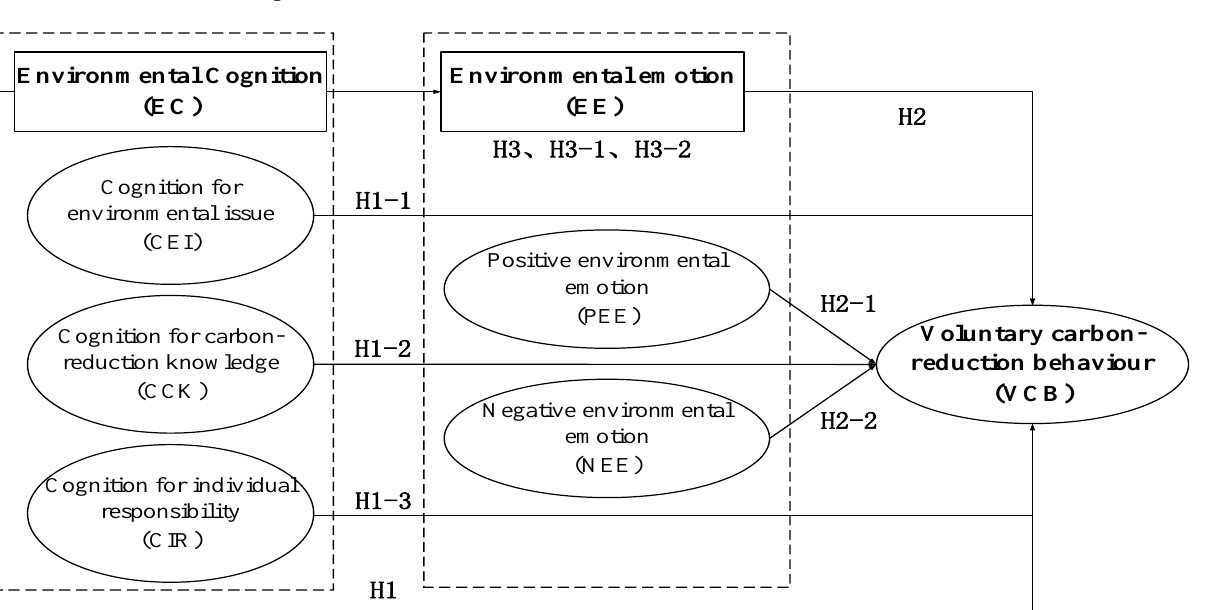
Figure 1. Conceptual model.